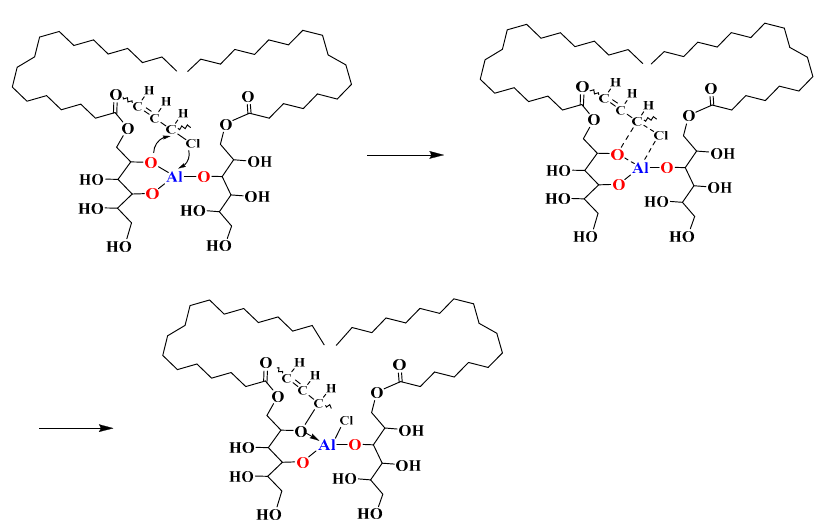
Figure 10. FTIR spectra of pure PVC and PVC stabilized by 4 phr of MSE-Al (heated at 180 °C for 30 min).